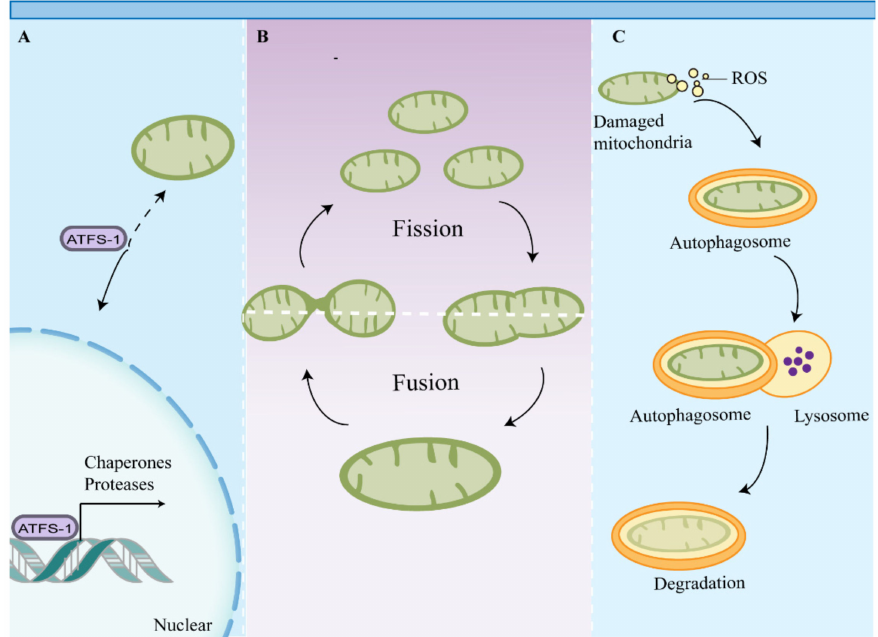
Figure 1. Mitochondrial quality control pathways. Multiple mitochondrial quality control